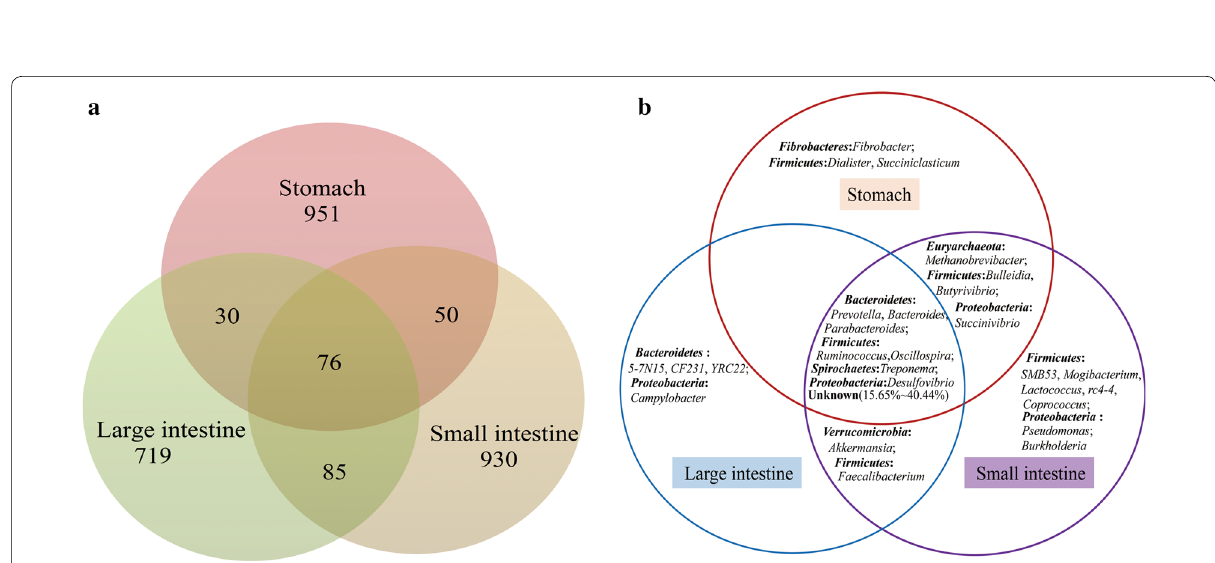
Fig. 4 Venn diagrams of shared OTUs and bacterial genera. The shared OTUs between the stomach, small intestine, and large intestine microbi- omes ( a ). The unique and shared bacterial genera (with the percentage of >1% colonized in segment) at the genus level in the sheep GIT ( b